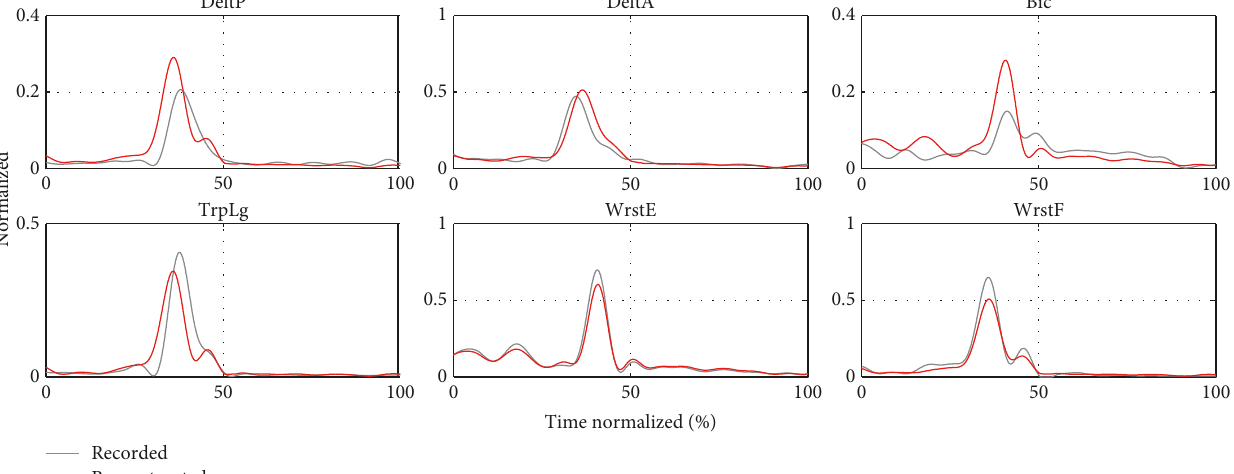
Figure 19: Example 1: activation reconstruction using W